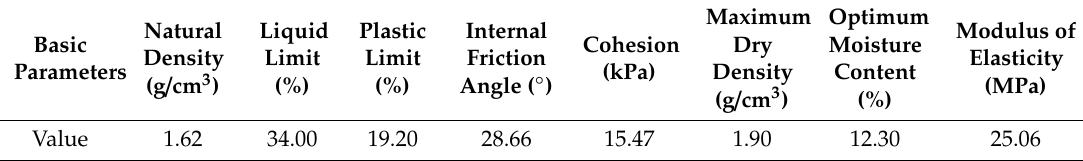
Table 1. Basic parameters of model